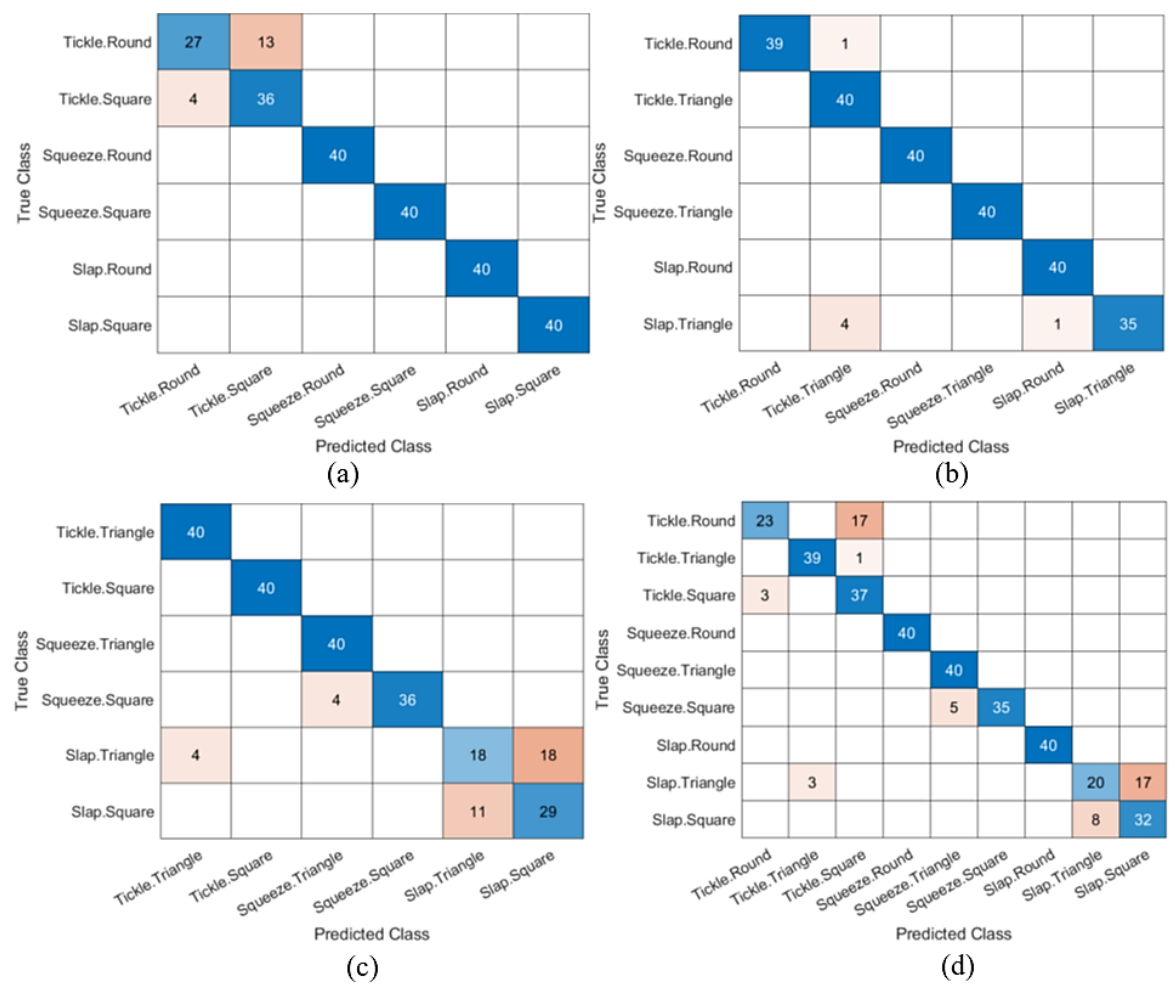
Figure 8. Confusion matrix of touch classification of different soft modules: ( a ) round vs square, ( b ) round vs triangle, ( c ) square vs triangle, and ( d ) all shapes.